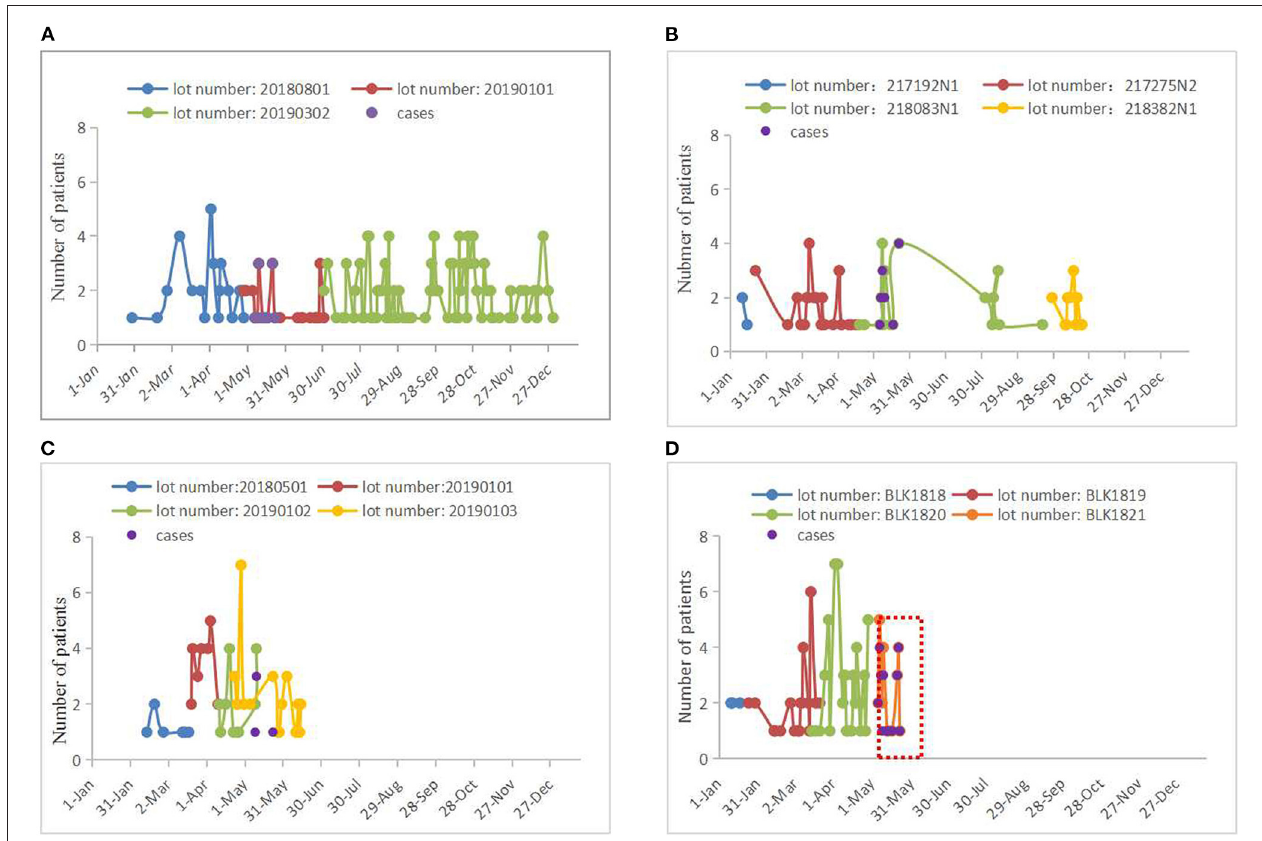
FIGURE 3 | Lot numbers, duration of use, and the number of patients treated with four biological material products in 2019. (A) Absorbable hemostat. There were three lot numbers of absorbable hemostat (20180801, 20190101, and 20190302) used by patients who underwent LC in 2019. The case group ( n = 13 cases) used products with the lot number of 20190101 from May 7 to May 23, 2019, but a total of 32 patients (conjunctival congestion of odds rate: 40.63%) used products from this lot number from April 28 to July 1 (see red line). Last used on December 31, 2019. (B) Tissue adhesive produced from enbucrilate. There were four lot numbers of tissue adhesive produced from enbucrilate (217192N1, 217275N2, 218083N1, and 218382N1) used by patients who underwent LC in 2019. The case group ( n = 13 cases) used products with the lot number of 218083N1 from May 6 to May 22, but a total of 29 patients (conjunctival congestion of odds rate: 44.83%) used products from this lot number from April 19 to September 19, 2019 (see green line). Last used on October 22, 2019. (C) Carboxylated poly(amino acid) polysaccharide medical biological glue. There were four lot numbers of carboxylated poly(amino acid) polysaccharide medical biological glue (20180501, 20190101, 20190102, and 20190103) used by patients who underwent LC in 2019. The case group used products with the lot number of 20190102 ( n = 4 cases) or 20190103 ( n = 1 case) from May 9 to May 23, 2019, but a total of 18 patients (conjunctival congestion of odds rate: 22.22%) used products with the lot number of 20190102 from April 11 to May 10 (see green line) and a total of 32 patients (conjunctival congestion of odds rate: 3.13%) used products with the lot number of 20190103 from April 23 to June 14 (see yellow line). Last used on June 14, 2019. (D) Modified chitosan medical membrane. There were four lot numbers of modified chitosan medical membrane (BLK1818, BLK1819, BLK1820, and BLK1821) used by patients who underwent LC in 2019. The case group ( n = 24 cases) used products with the lot number of BLK1821 from May 6 to May 23, with a total of 28 patients (conjunctival congestion of odds rate: 85.71%) using products from this lot number from May 6 to May